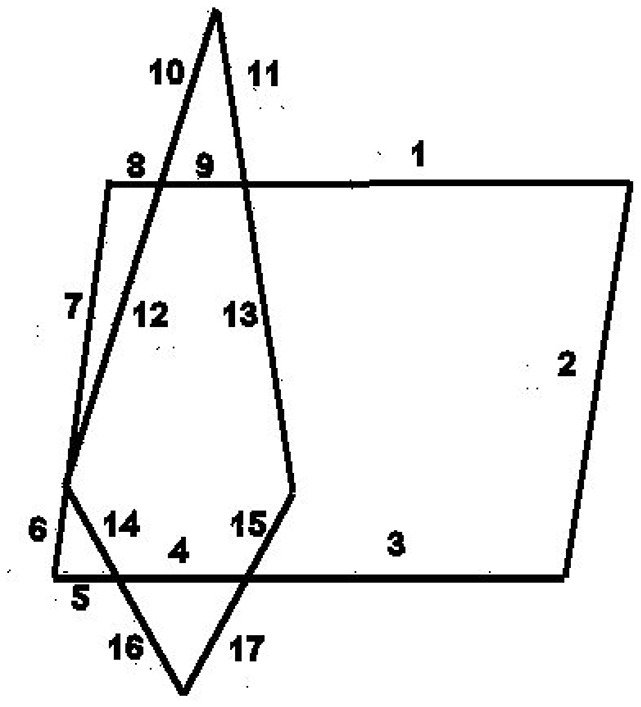
Following the strocks (Wertheimer, 1923).